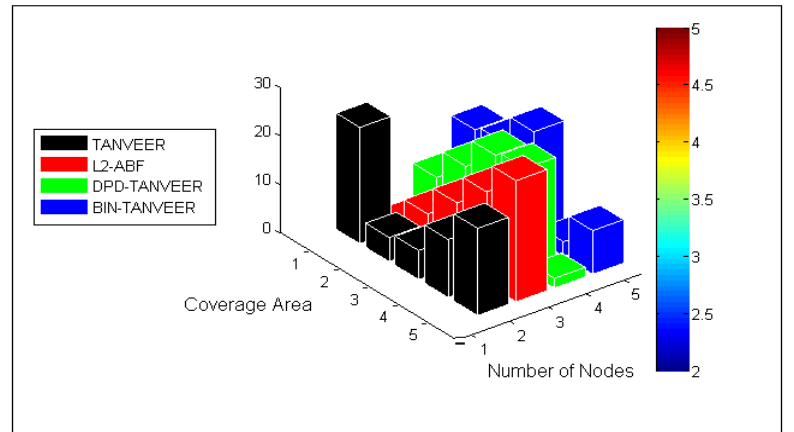
Figure 16. Analysis of coverage area.